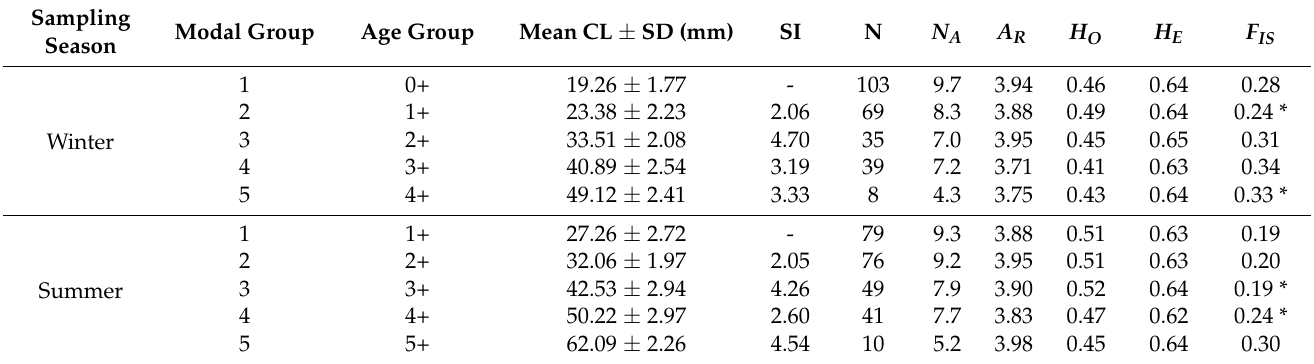
Table 2. Description of the groups identified through the modal progression analysis of the carapace length (CL) frequency distributions of A. antennatus females, including sampling season, modal and age group, mean carapace length with standard deviation (SD), separation index (SI), number of females (N), and estimates of genetic diversity (excluding locus Aa818 ).